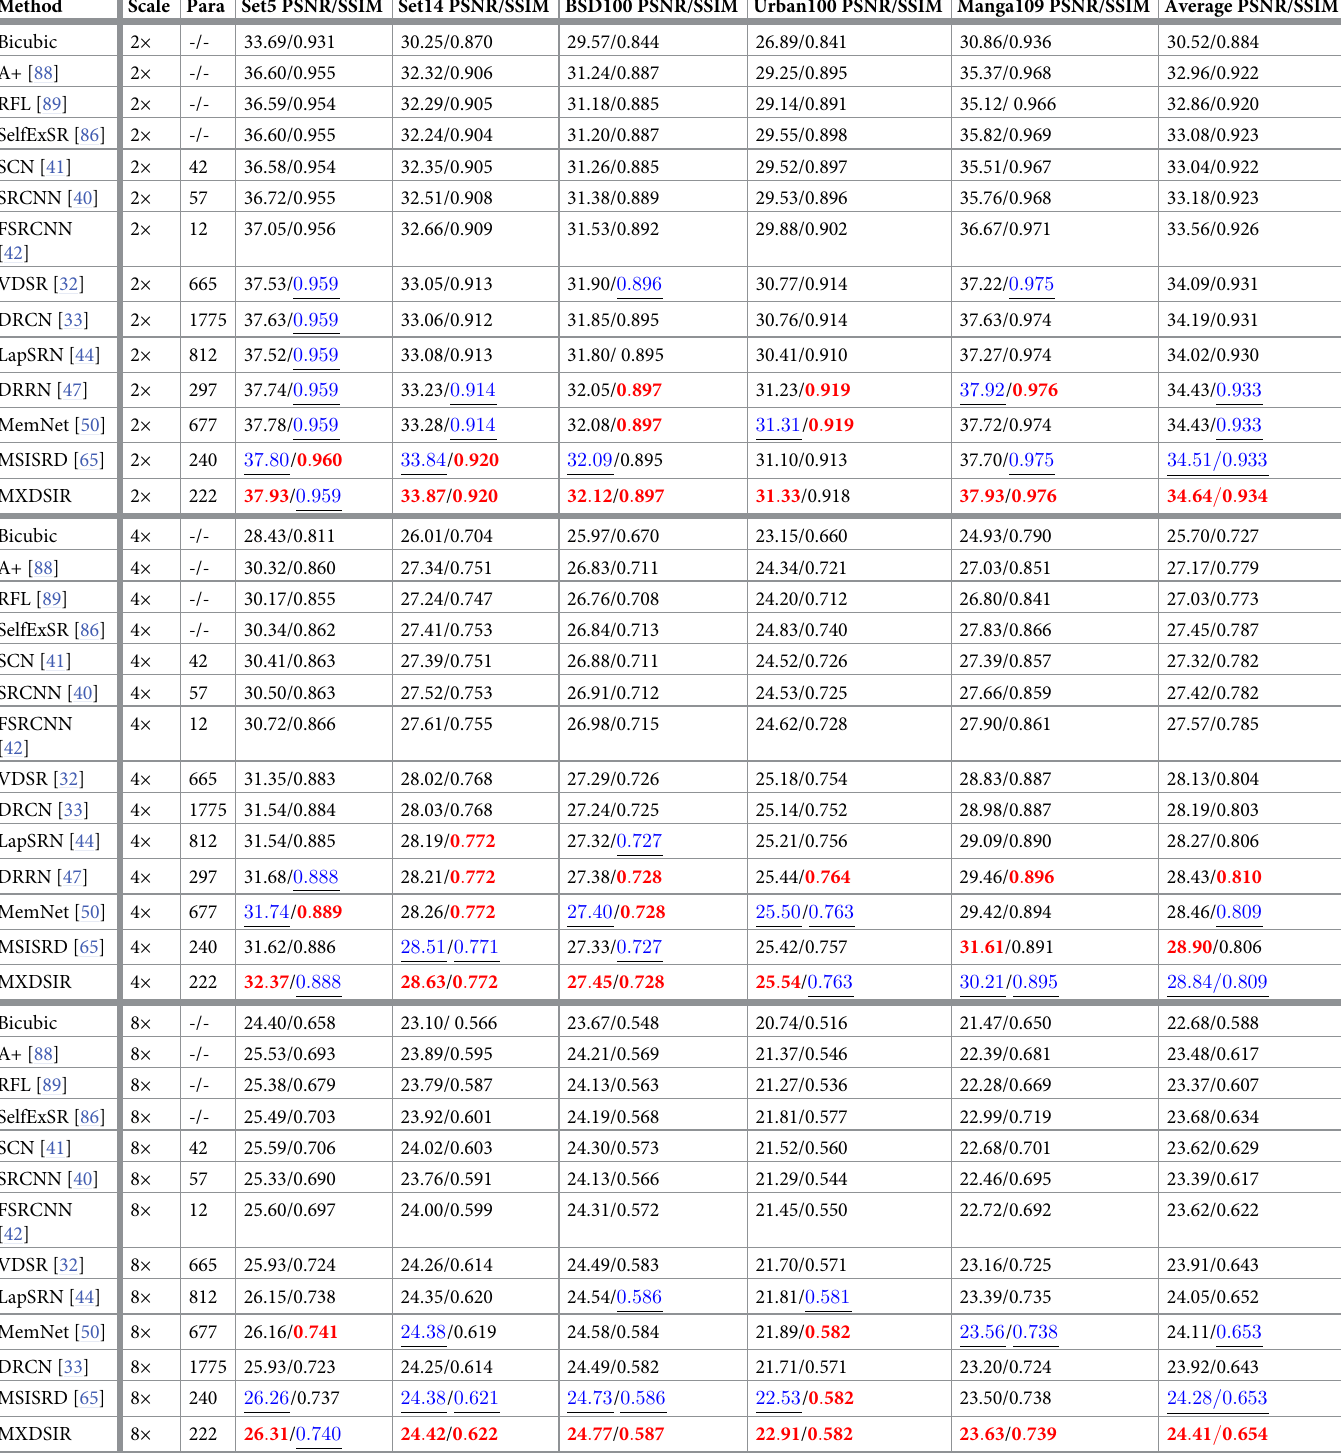
Table 1. Presents benchmark results of the average value of PSNR/SSIM [81] for enlargement factor 2 × , 4 × , and 8 × on Set5 [84], Set14 [85], BSD100 [82], Urban100 [86], and Manga109 [87] test datasets. Bold indicated results with red colors are the best values. The underlined results with blue color are second (cid:0) best values.